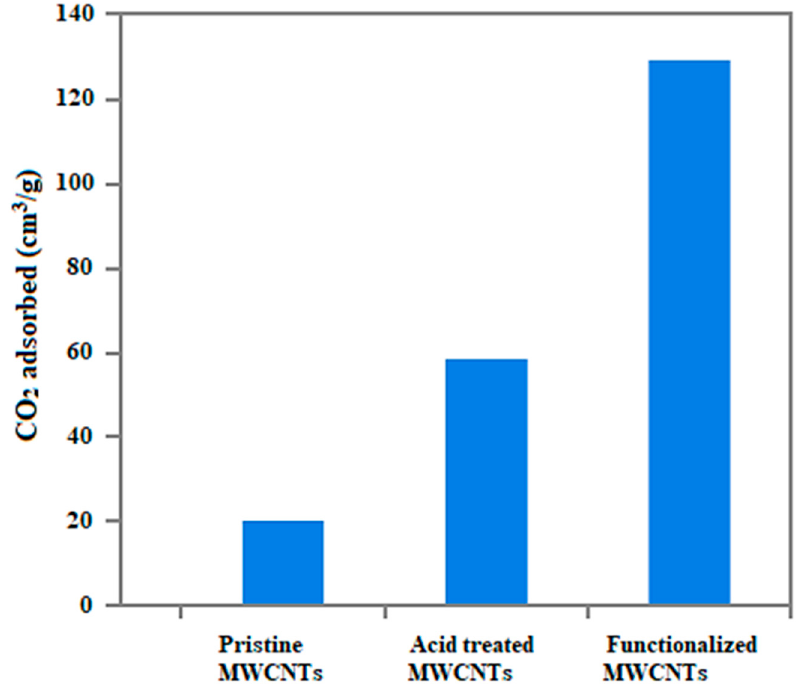
Figure 12. CO 2 adsorption capacities of pristine and modified MWCNTs.